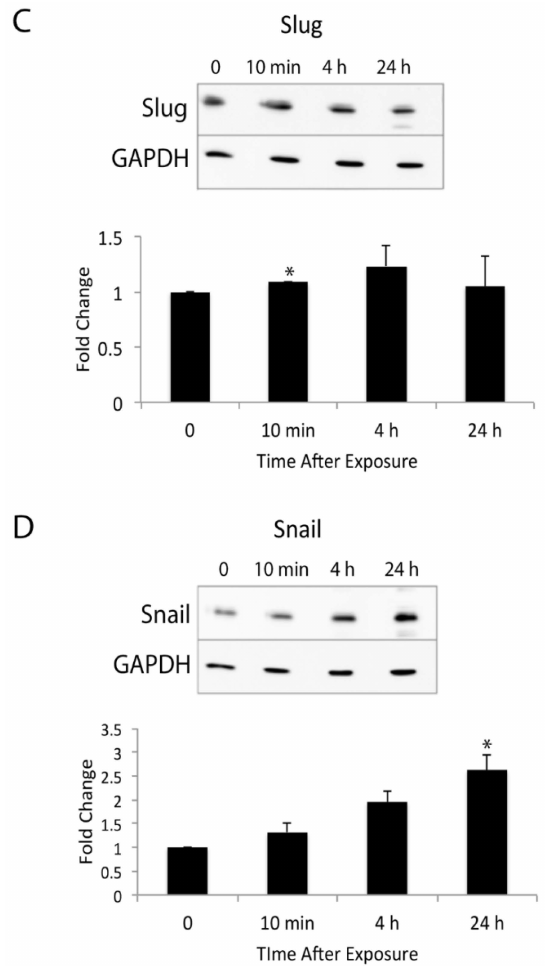
Figure 5. TPA alters the expression of Slug and Snail mRNA and protein in cultured NHK cells. ( A , B ) NHK cells were treated with TPA or acetone and harvested at later time points; 0 h samples were from untreated cells. mRNA was isolated, and Slug and Snail expression levels were determined by q-RT-PCR. Results are shown as a fold increase compared to 0 h samples. Results were compared by ANOVA followed by the Bonferroni correction. * Significantly different from 0 h samples. Bars indicate SEM. ( C , D ) SCC12F cells were treated with TPA and harvested at later time points; 0 h samples were from DMSO-treated cells. Protein was isolated, and Slug and Snail expression levels were determined by Western blotting followed by densitometry. Results are shown as a fold increase compared to DMSO-treated samples. Results were compared by a one-tailed Student t -test assuming unequal variance. * Significantly different from 0 h samples. Bars indicate